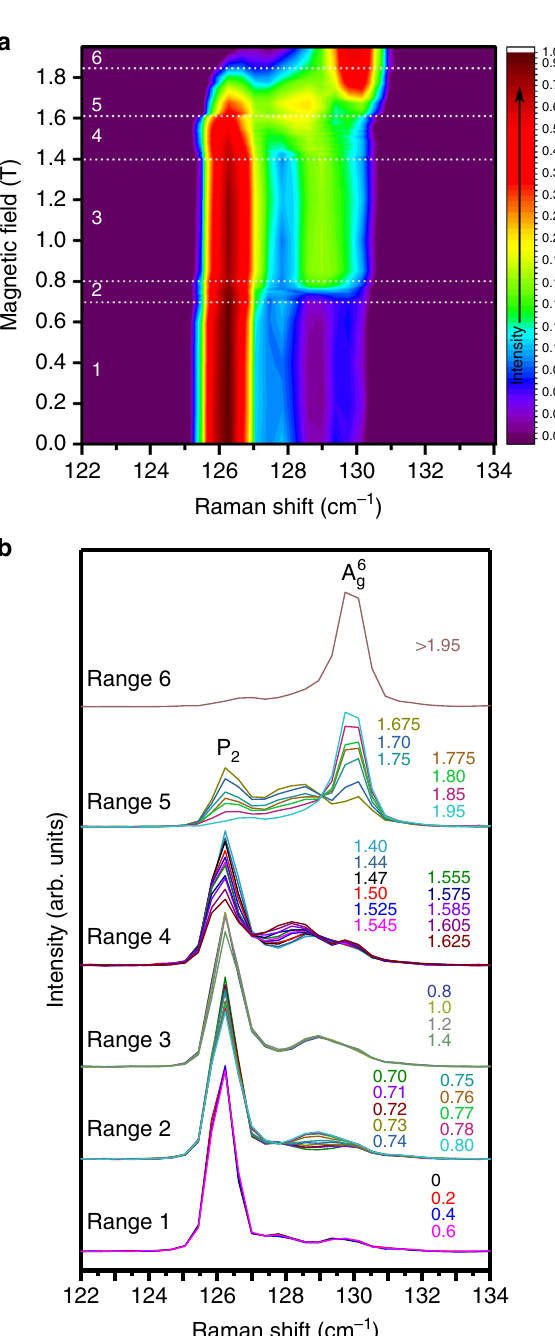
Fig. 3 Distinct magnetic fi eld ranges in CrI 3 . a False-color contour map of the Raman intensity (logarithmic) vs. magnetic fi eld and Raman shift frequency. b Raman spectra at T = 9 K, showing a detailed view of the 122 cm − 1 to 134 cm − 1 frequency range at different magnetic fi elds given by legend values (in Tesla). Six distinct fi eld regions are identi fi ed below 2 T. A vertical offset was applied to spectra in the different fi eld ranges for